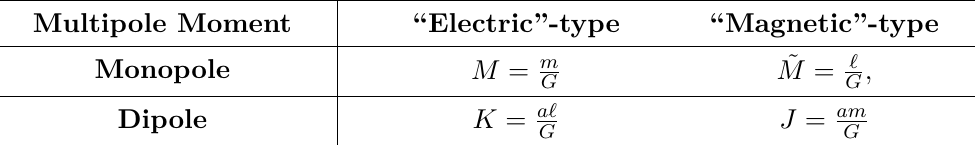
Table 3 . Asymptotic charges of the Kerr-Taub-NUT solution. The leading BMS charges are described by the monopole moments of the Weyl scalar ψ 2 while the subleading BMS charges are described by its dipole moment. At each order the charges can be classify into “electric” and “magnetic” types according to their